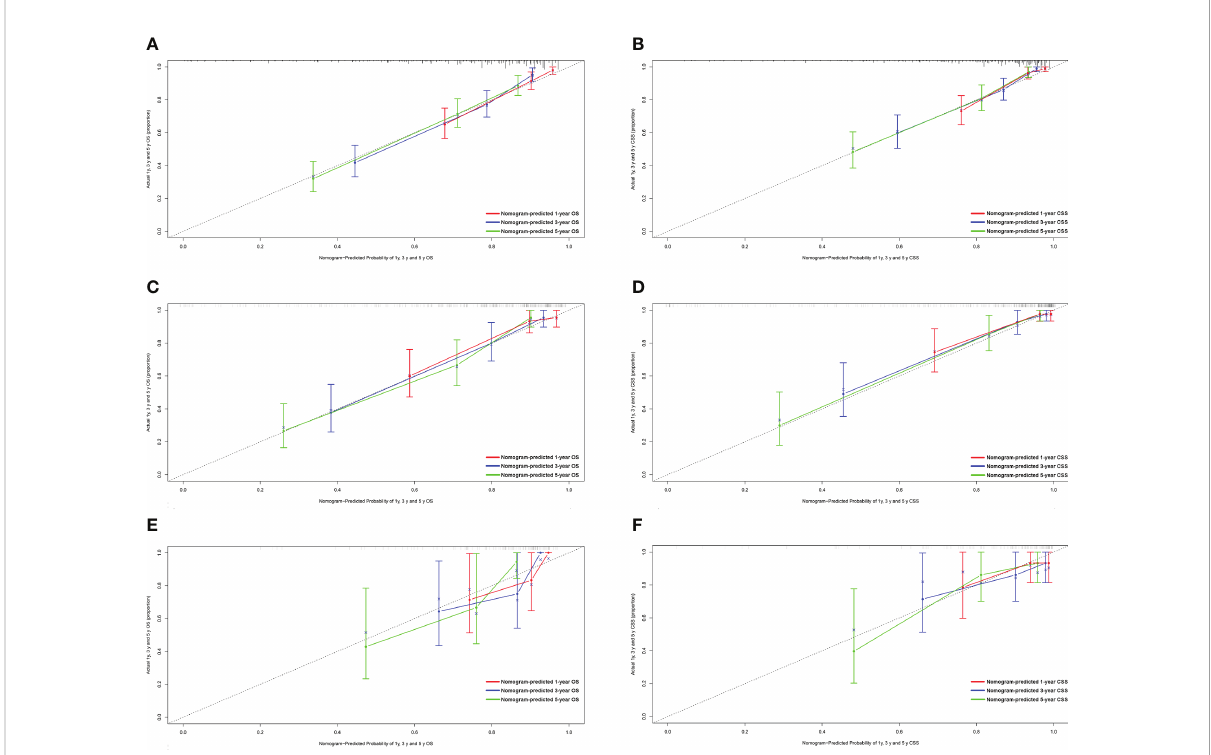
FIGURE 4 Calibration plots of the nomogram for 1-, 3- and 5-year OS and CSS prediction. (A) Calibration curves of 1-, 3- and 5-year OS in the training cohort; (B) Calibration curves of 1-, 3- and 5-year CSS in the training cohort; (C) Calibration curves of 1-, 3- and 5-year OS in the internal validation cohort; (D) Calibration curves of 1-, 3- and 5-year CSS in the internal validation cohort; (E) Calibration curves of 1-, 3- and 5-year OS in the external validation cohort; (F) Calibration curves of 1-, 3- and 5-year CSS in the external validation cohort. OS, overall survival; CSS, cancer-speci fi c